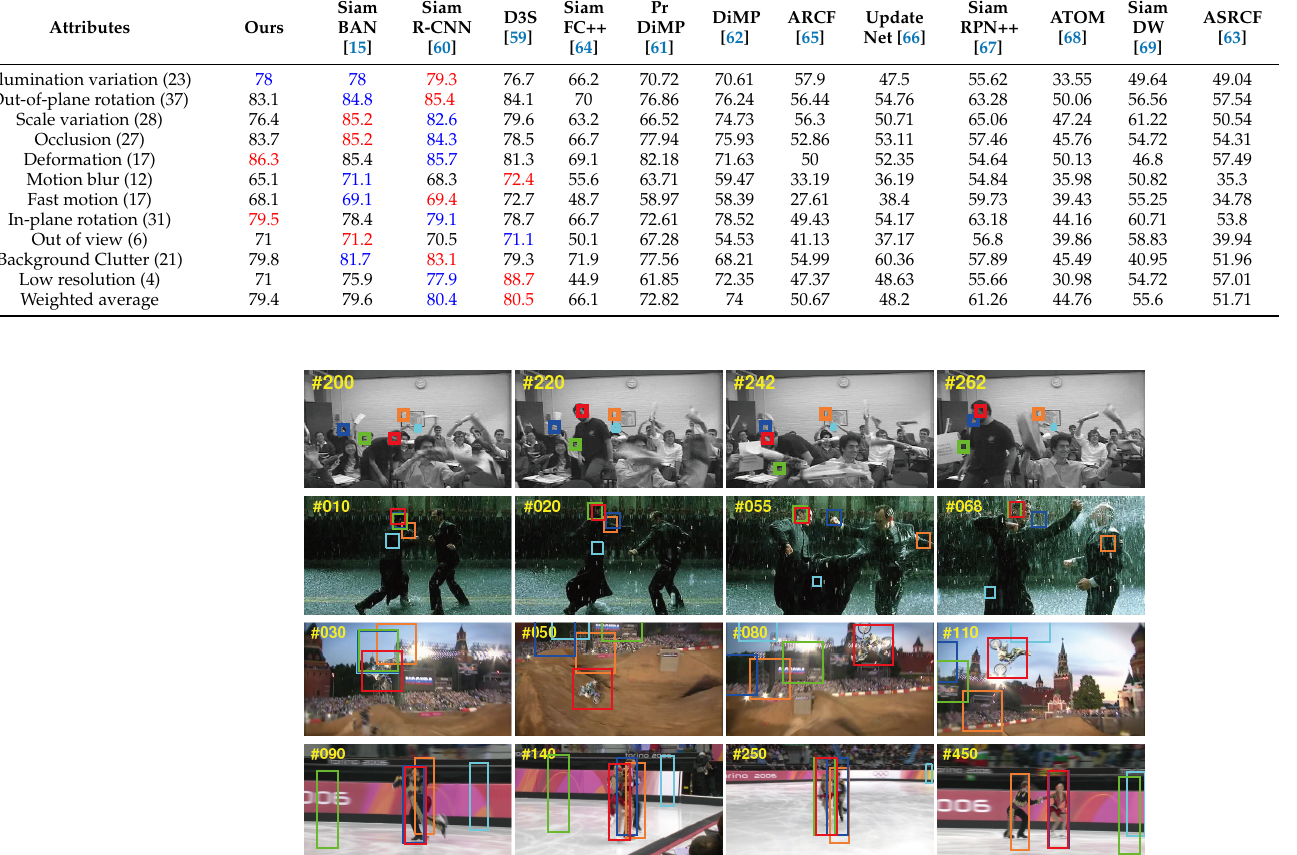
Table 3. Distance precision scores (%) in terms of individual attributes on the OTB-100 datasets. Attributes